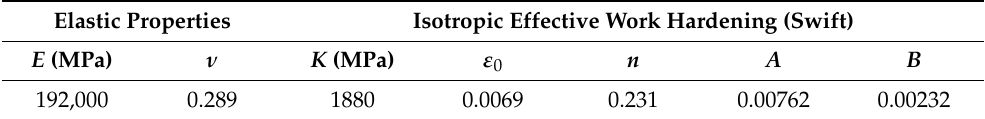
Table 5. Elastic properties and parameters of the isotropic effective work hardening. Elastic Properties